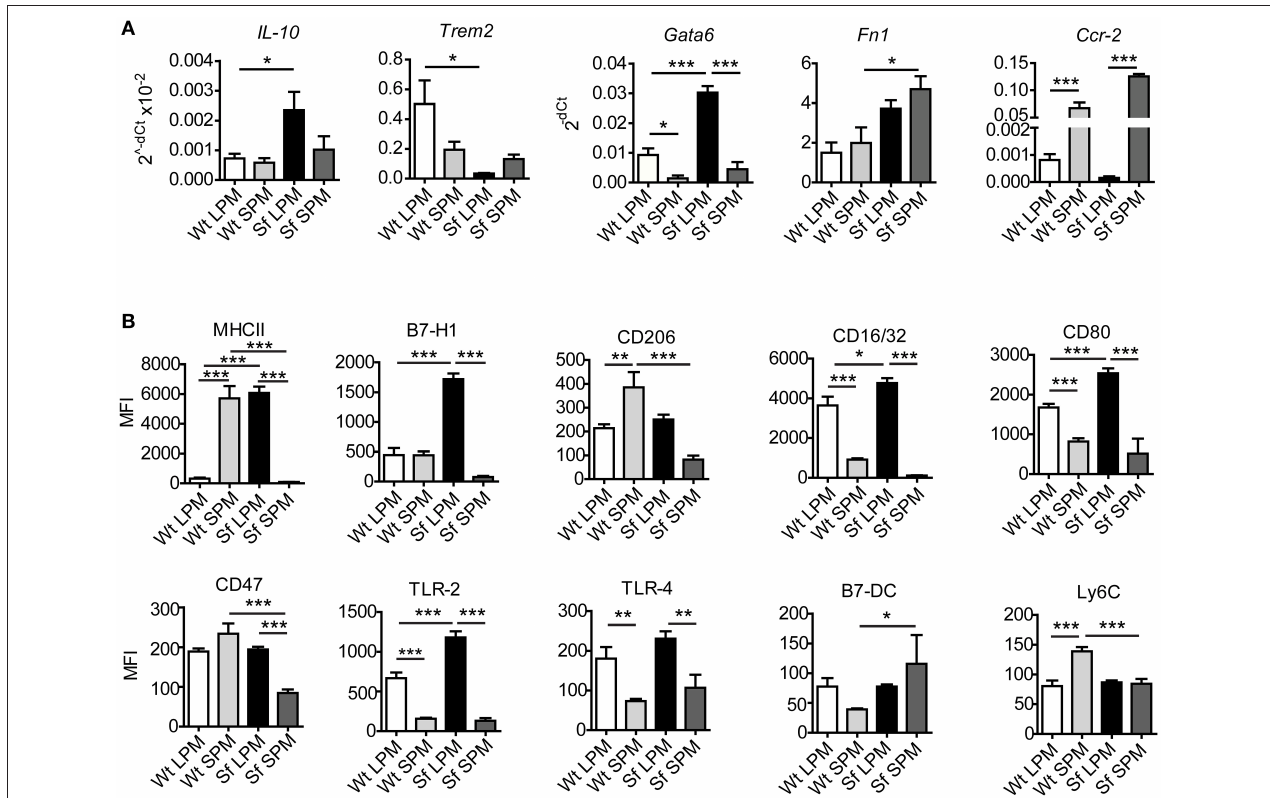
FIGURE 6 | Large and small peritoneal macrophages have distinct immune profiles in steady-state and inflammatory conditions. (A) Quantitative PCR analysis of gene expression in large and small peritoneal macrophages (LPM and SPM), isolated from scurfy (Sf) and control (Wt) mice ( n = 4–7 samples per group, each sample contains pooled cells from 3 to 7 mice). (B) Expression pattern of cell surface markers involved in immune response in LPM and SPM analyzed by single-cell chipcytometry. Data are depicted as mean fluorescent intensities (MFI) for each surface marker expressed by single cells ( n = 28–62 cells per experimental group, each sample contains pooled cells from more than 8 donor